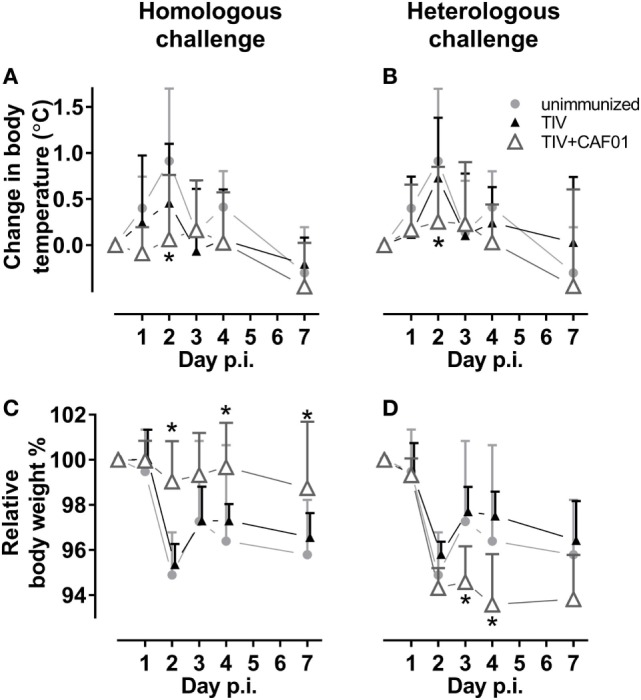
CAF01 adjuvantation reduces fever after both a homologous and a heterologous challenge. Ferrets immunized two times with either the seasonal trivalent influenza split-virion (TIV)2007 (A,C) or the seasonal TIV2009 (B,D) vaccine without adjuvant (▴) or with CAF01 adjuvant (▵). Unimmunized controls (). Challenge with the A/Brisbane/59/2007 influenza strain. Changes in relative body temperature (A,B) were determined by rectal measurements, where an average of day −1 and 0 were set to 0 and the difference was determined as that on the day of measurement minus the starting point. Relative weight (C,D) were determined by measurements where an average of day −1 and 0 were set to 100% and the difference was determined as day of measurement divided by the starting point. Shown are mean values + SD (n = 8). Statistical analysis: repeated-measures two-way ANOVA based on the data shown in each graph. Dunnett’s test was used to compare the unimmunized to the two other groups. Asterisks show statistically significant differences compared to the unimmunized group (p < 0.05).